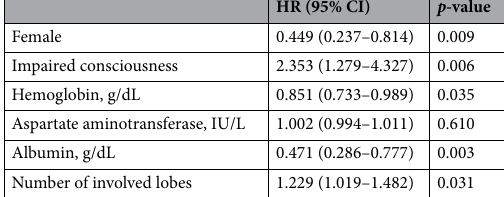
Table 6. Multivariate Cox hazard regression analysis of the baseline characteristics associated with in-hospital mortality. CI, confidence interval; HR: hazard